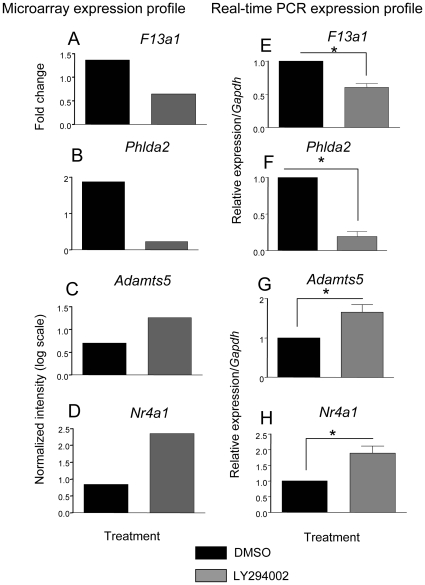
Real-time RT PCR confirmation of selected genes: F13a1, Nr4a1, Adamts5, Phlda2.Real-time PCR demonstrates that relative transcript levels for F13a1 and Phlda2 were decreased in LY294002 treatment after 24 hours while Adamts5 and Nr4a1 transcripts were increased in response to LY294002. Data were normalized to Gapdh (Glyceraldehyde 3-phosphate dehydrogenase) mRNA levels. The results represent average fold change between DMSO and LY294002 treatments from 4 independent trials (n = 4). T-test -2 sample unequal variance was used and a *p-value <0.05 was considered significant.